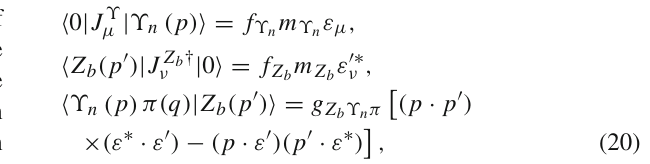
Within theoretical errors m Z is in agreement with exper- b imental measurements of the Belle Collaboration (1). The mass and current coupling Z b given by Eq. (16) will be used as input parameters in the next sections to find the widths of the decays Z b → ϒ( nS )π and Z b → h b ( mP )π